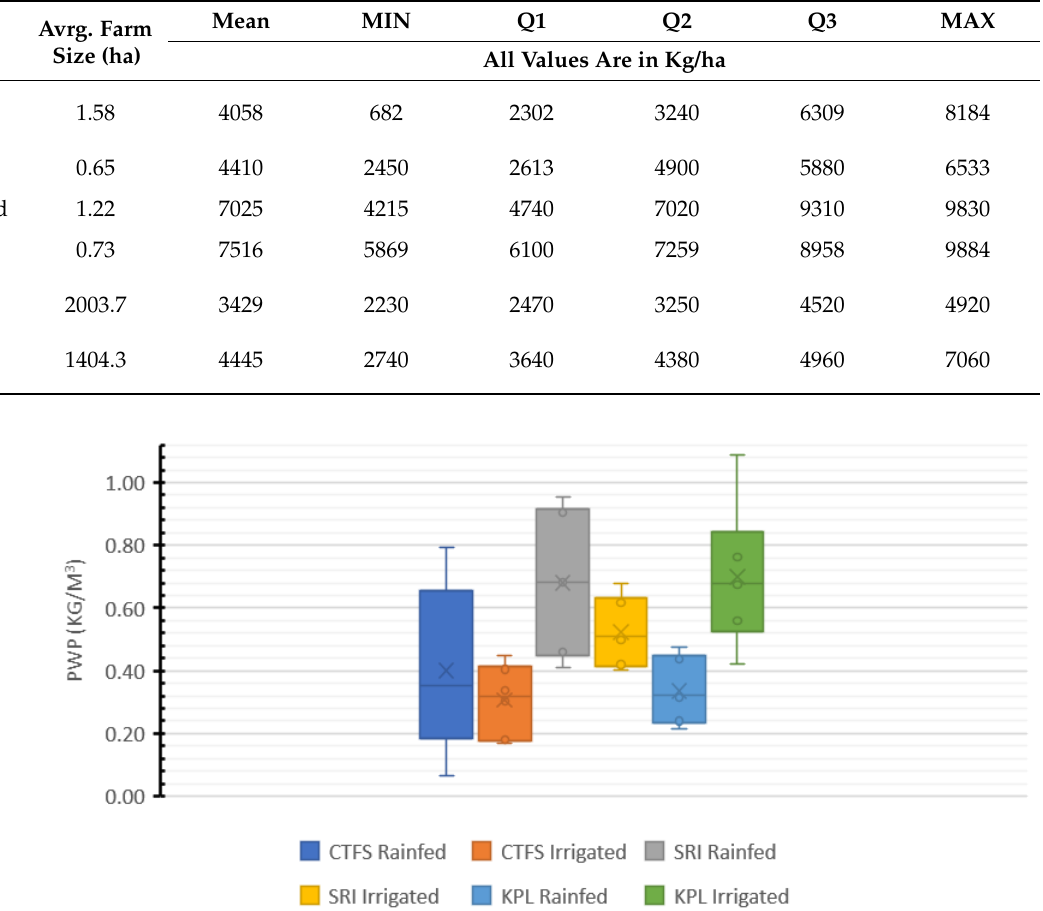
Table 4. Descriptive statistics for paddy harvests in the study area. Source: [42].